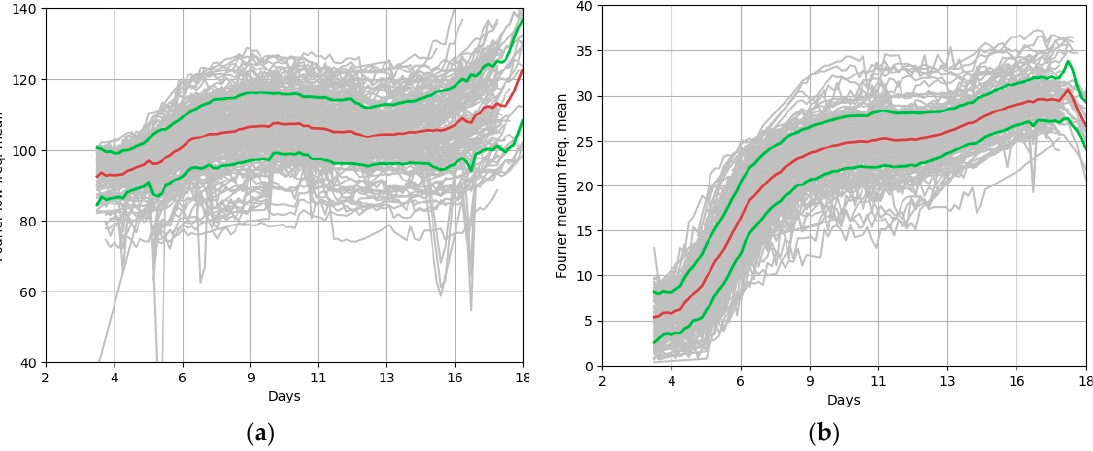
Figure 13. Results of Fourier analysis for low pass mean ( a ) and, medium pass mean ( b ) filter intensity. The brown line represents the medium value, the green line represents standard deviation.